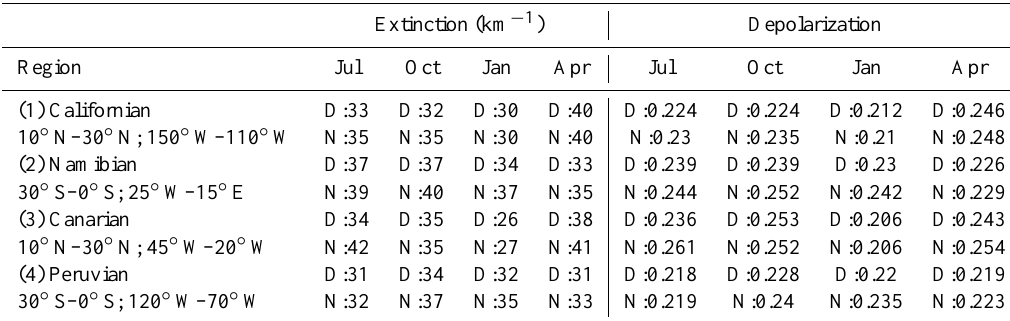
Fig. 4. Comparison of water cloud top mean extinction coefficient by using slope method and Hu’s method. The x -axis is for slope method, y -axis is for Hu’s method. Black dots are mean values and horizontal black shorter lines are the error bars.